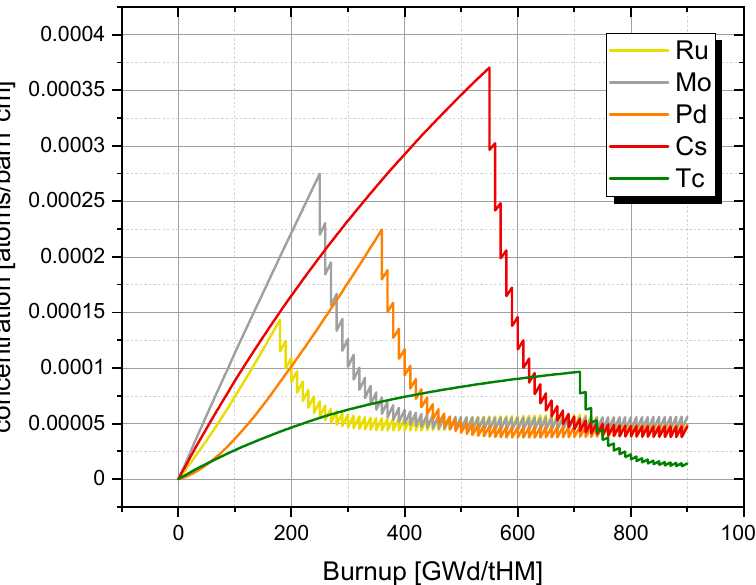
Figure 13. Development of the fission product elementary content over burnup, considering the stepwise separation of different elements, based on a simulation using 10 GWd/tHM steps and an initiation of the clean ‐ up system after 50 GWd/tHM.